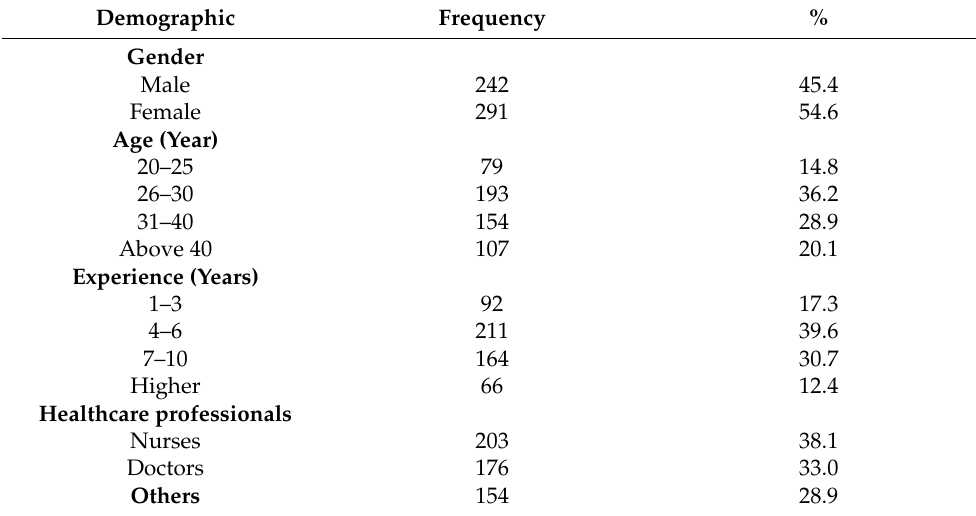
Table 1. Demographic information of the